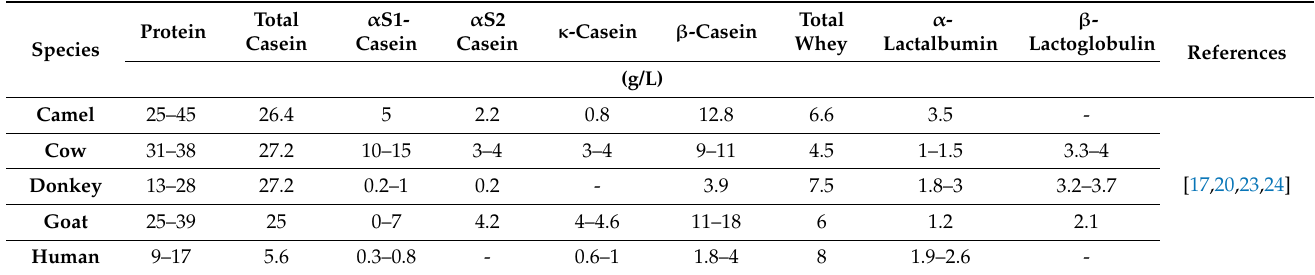
Table 2. Major proteins present in the milk of different